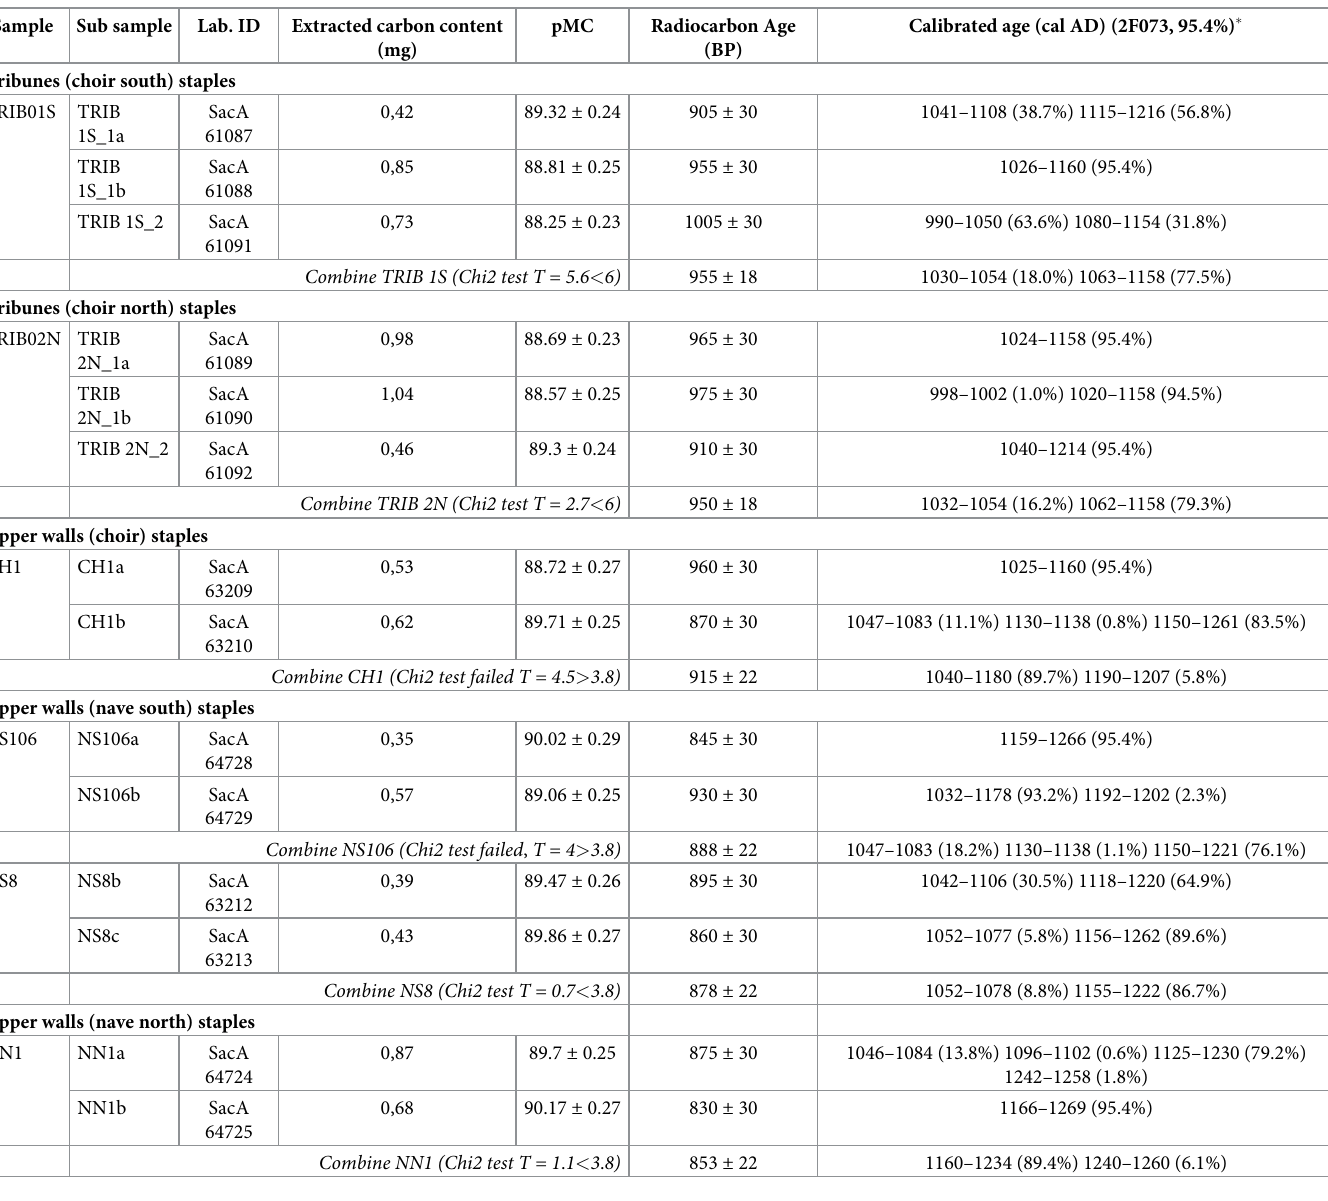
Table 4. Results of radiocarbon dating on the staples of Notre-Dame de Paris. Sample Sub